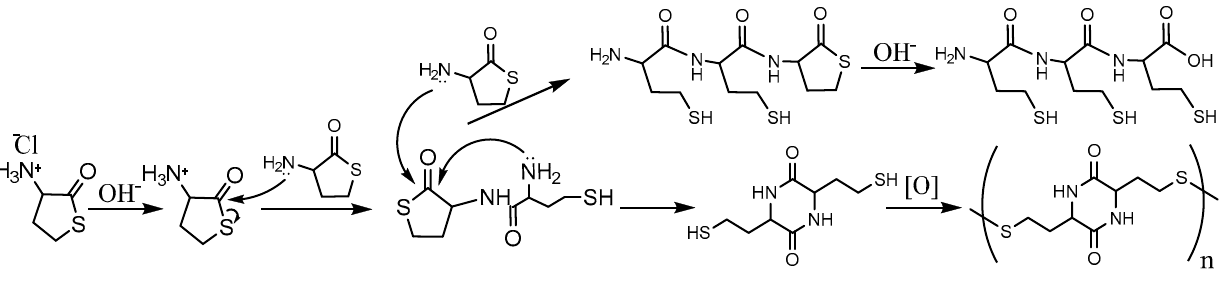
Figure 2. HTL reactions in alkali solution.